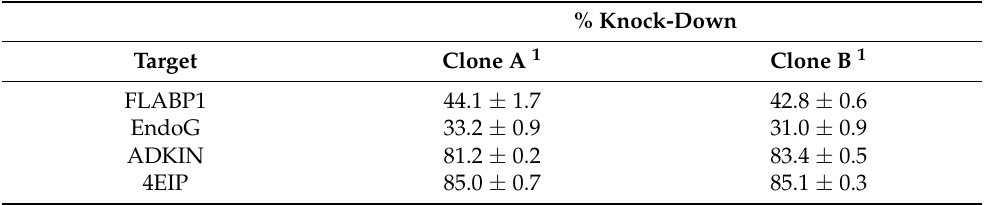
Table 2. Overview of the RNA knock-down levels following in vitro induction with tetracycline.